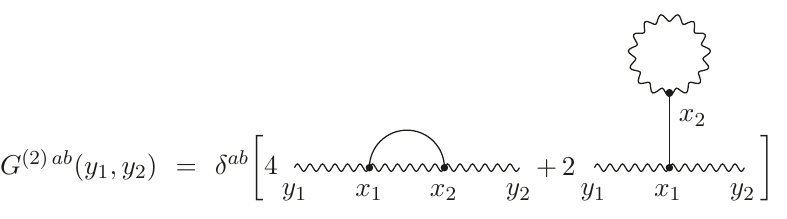
Figure 2 . Relevant one-loop diagrams for the two-point function of the (cid:12)eld (cid:30) a in the order g 2 within the fundamental theory in the coordinate